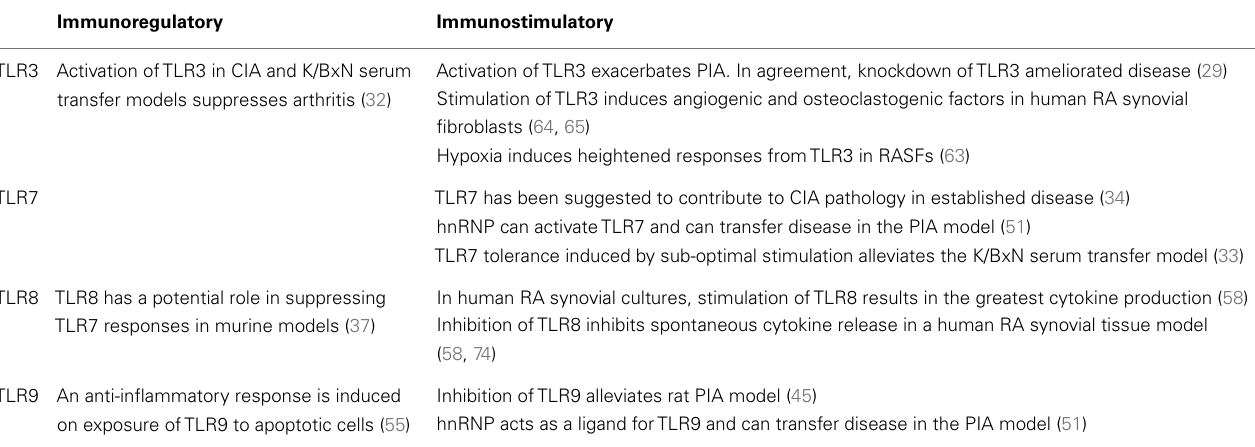
Table 1 | Dual nature of endosomalTLR signaling in RA and disease models